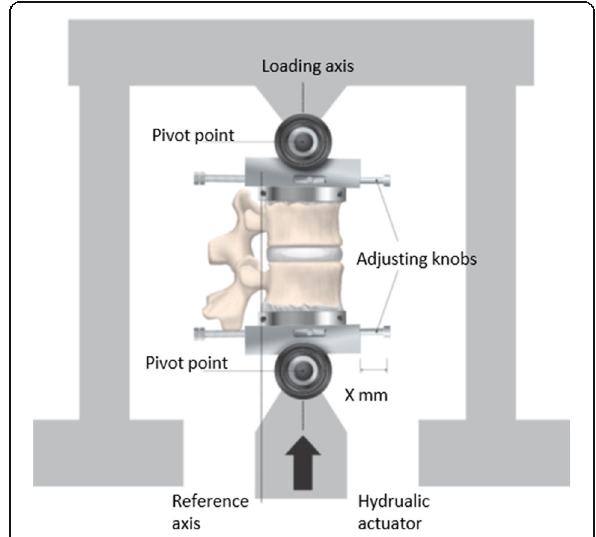
Fig. 1 Schematic view of the experimental set up in the MTS testing machine